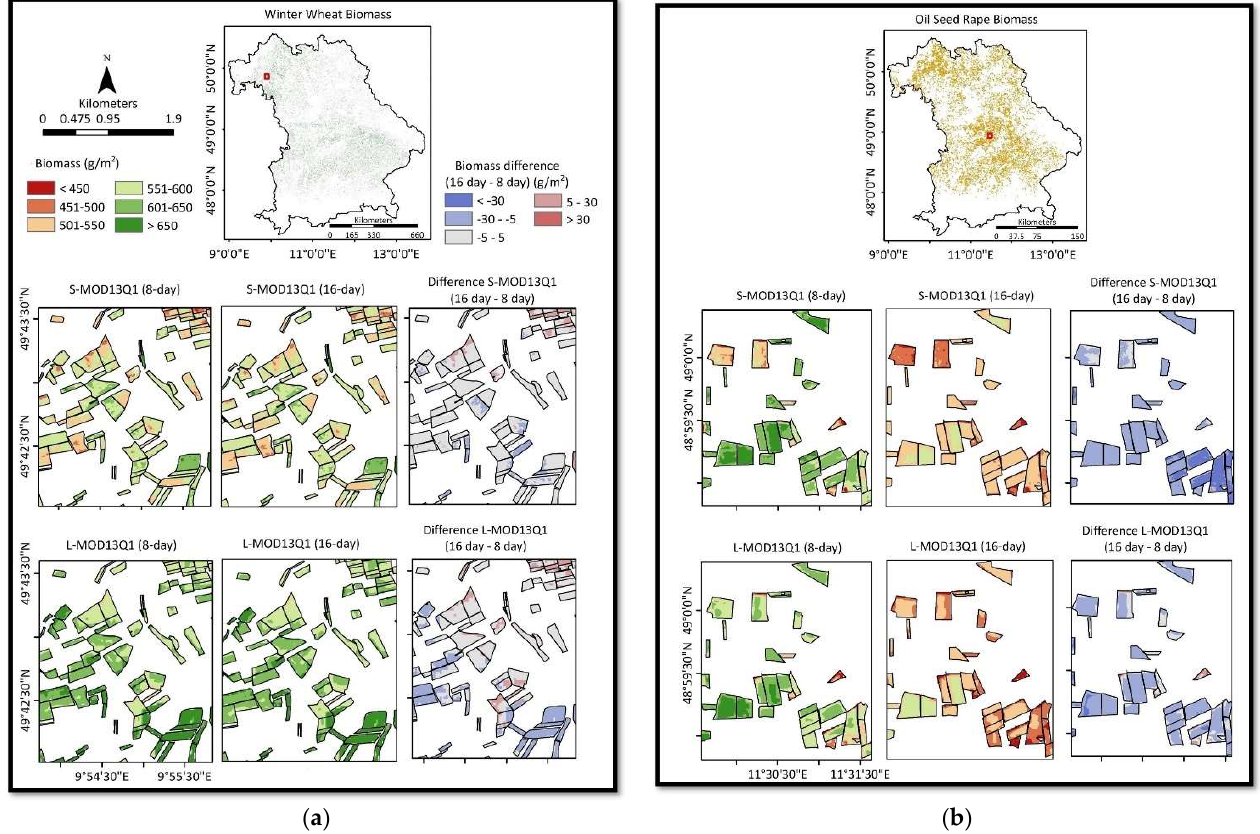
Figure 17. Visualisation of field level biomass of L-MOD13Q1 and S-MOD13Q1 with 8 days, 16 days, and the difference (16–18 days) obtained using the LUE model for ( a ) WW and ( b ) OSR.